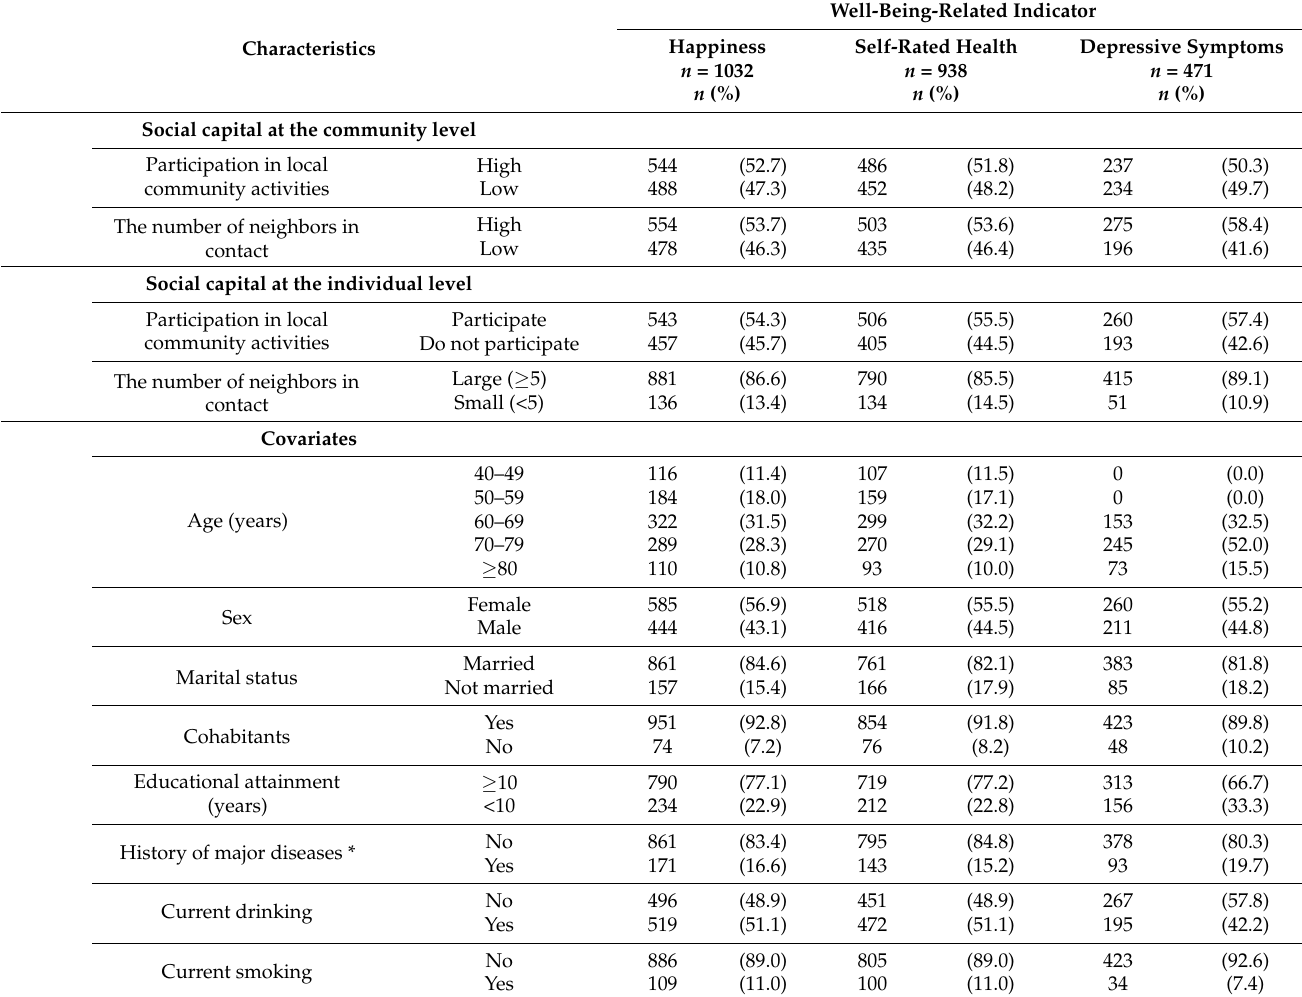
Table 1. The baseline characteristics of the study population for each well-being-related indicator.